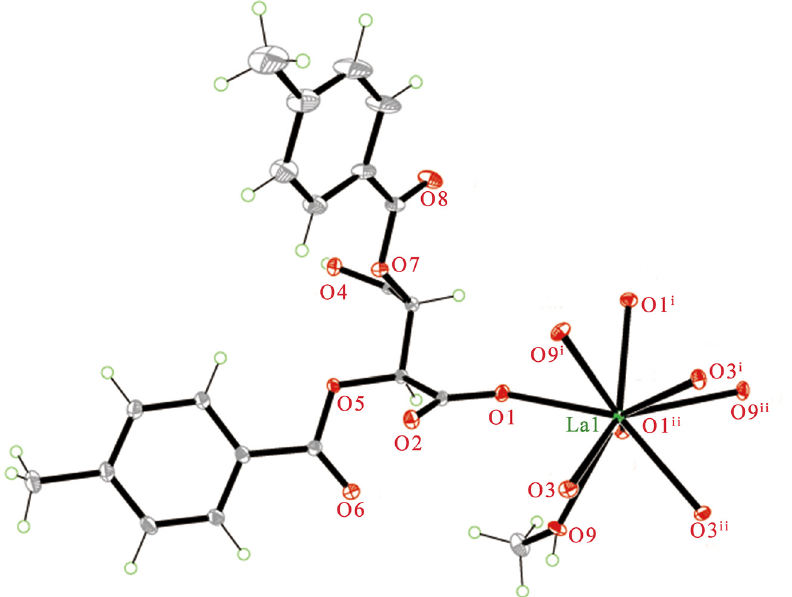
Table  : Data collection and